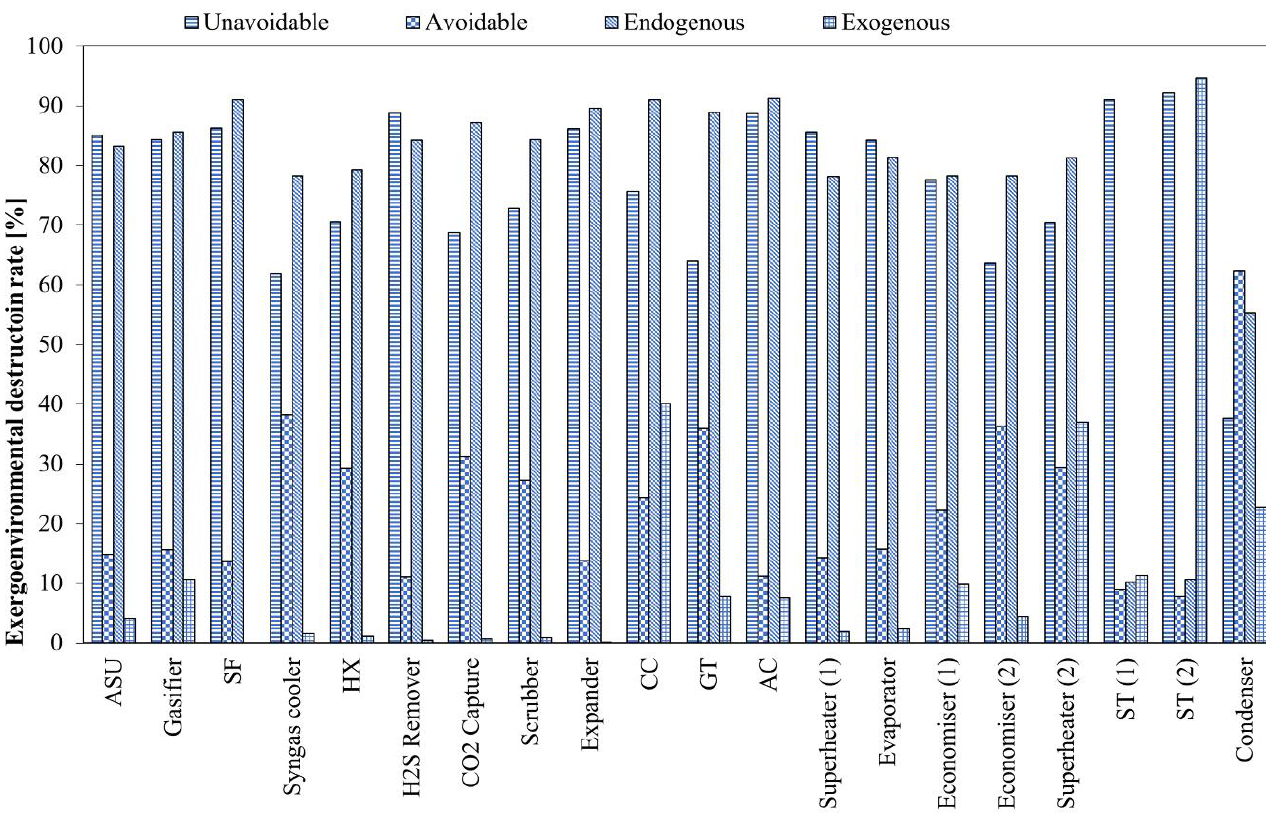
Figure 7. Advanced exergoenvironmental analysis results obtained for the proposed integrated solar-gasification cycle (ISGC) system. ASU: Air separation unit; CC: Combustion chamber; GT: Gas turbine; HX: heat exchanger; SF: Solar field; ST: Steam turbine. Table 7. Ranking of equipment obtained from conventional and advanced exergy analyses.